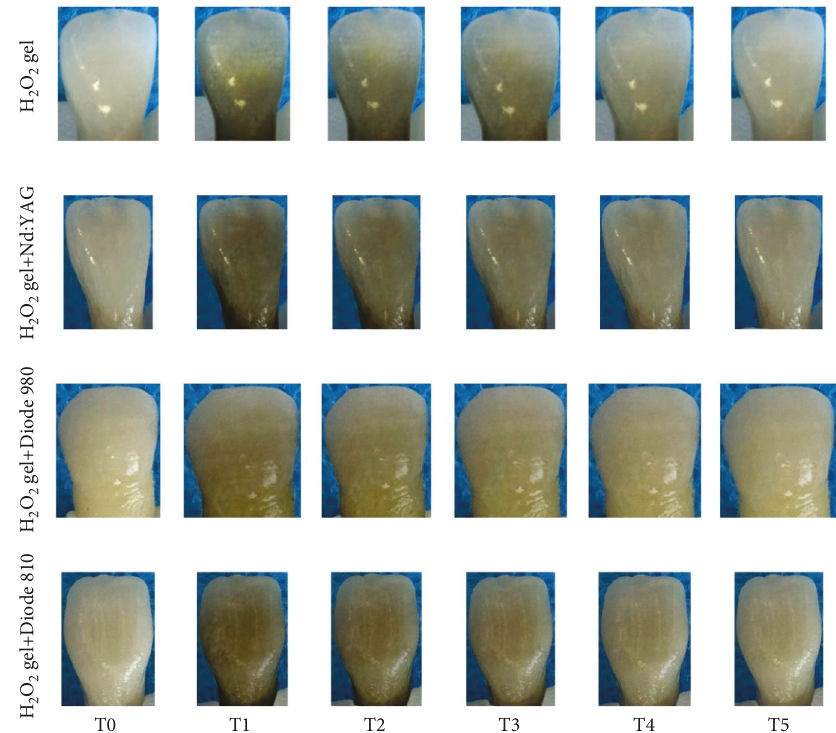
Figure 3: Representative images of the specimens in each experimental group during the